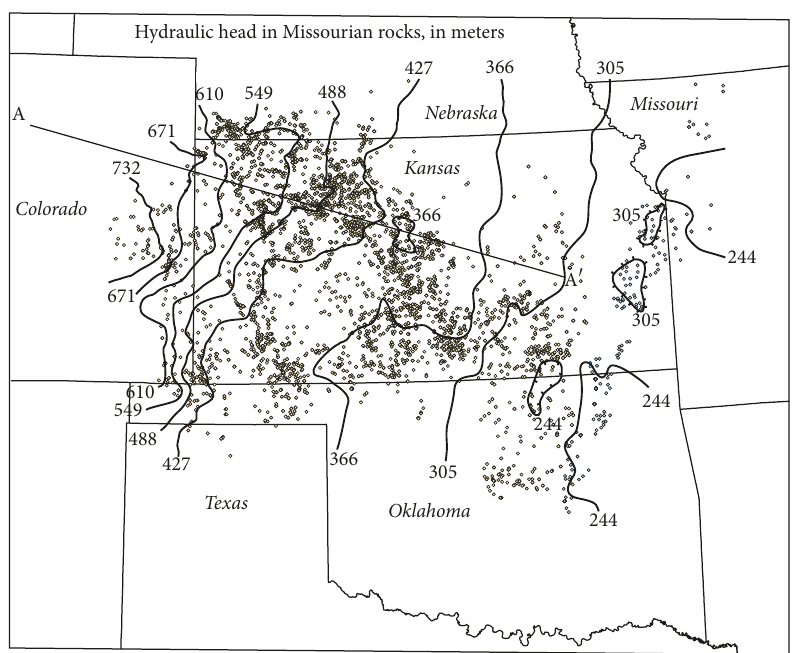
Figure 10: Map of potentiometric surface (hydraulic head contour lines in meters) in rocks of Missourian age, after Nelson et al. ([7], Figure 14C). Hydraulic head ranges from less than 244 m in water wells in Missouri and Oklahoma to greater than 732 m in oil and gas wells in eastern Colorado. Dots represent well control. Control data for the hydrologic model were taken along 800 km line A-A 󸀠